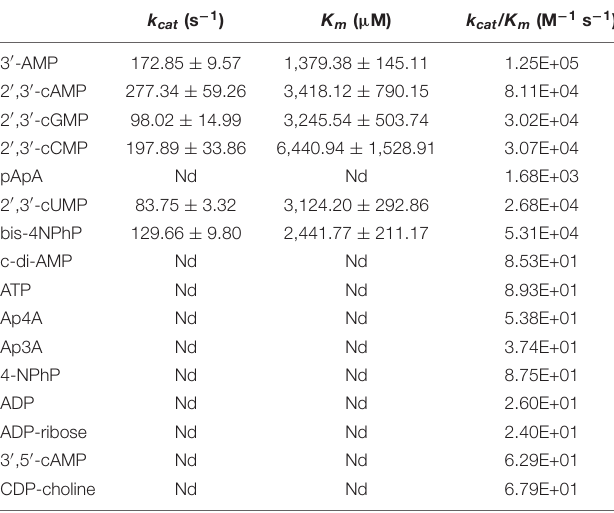
TABLE 2 | Kinetic parameters of Y530A-SntA.